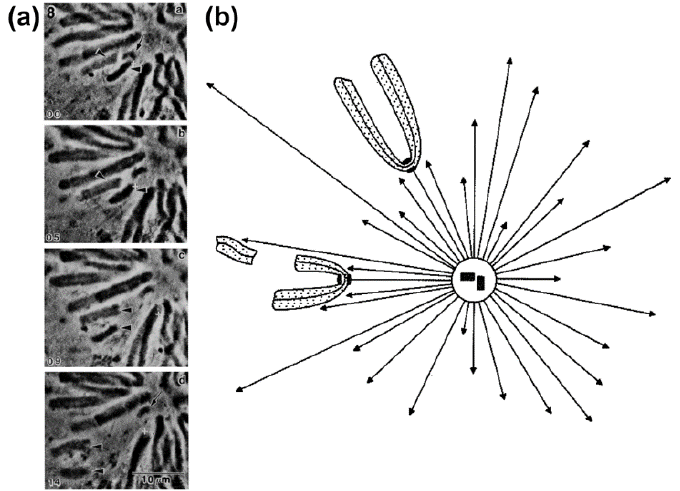
Figure 4. Demonstration that polar ejection forces act along the entire chromosome. ( a ) Phase contrast image of a newt lung cell in which the chromosome arms on one chromosome (arrowheads) were physically separated from the kinetochore region using laser microsurgery. Note the ejection of the acentric chromosome arms away from the polar region. In contrast, the kinetochore-containing region (arrow) moves closer to the polar region. Reprinted from Rieder et al., 1986 [43] and displayed under